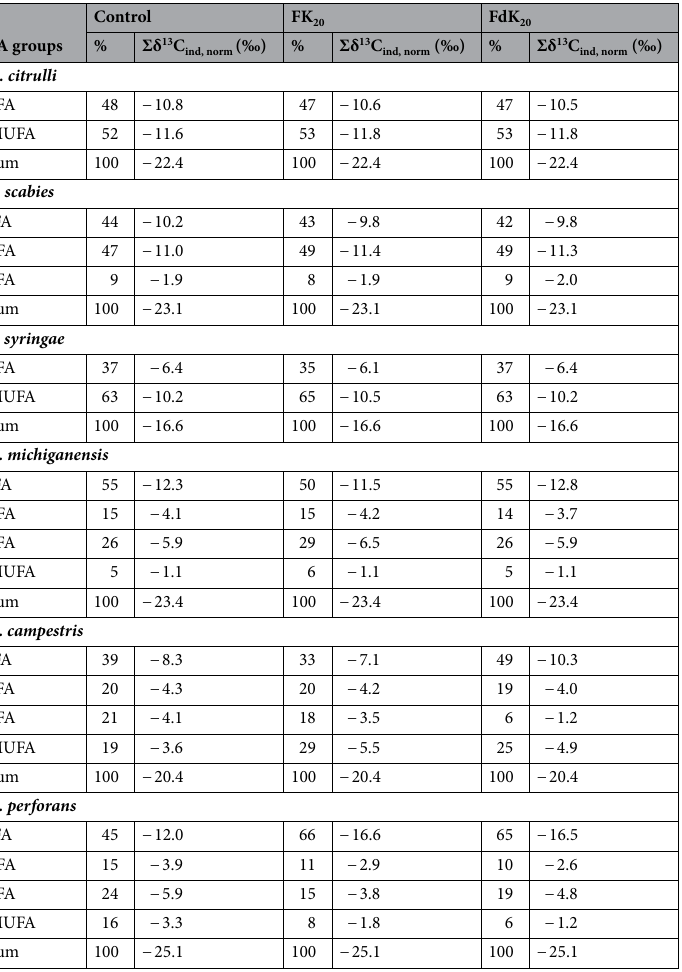
Table 5. Percentage distribution of fatty acid groups of all six plant-pathogenic bacteria and contribution to Σδ 13 C ind, norm values (‰) obtained from GC-C-IRMS of individual FAs and Σδ 13 C ind, norm values (‰) of control and FK 20 -/FdK 20 -treated samples. With SFA Saturated fatty acids, MUFA Monounsaturated fatty acids, iFA iso - fatty acids, aFA anteiso -fatty